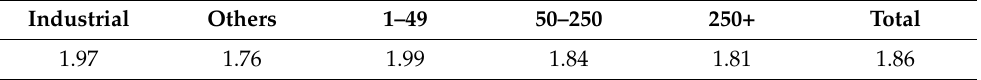
Table 7. Residual risk calculation, according to formula (1), for the assumed inherent risk index = 20. Industrial Others 1–49